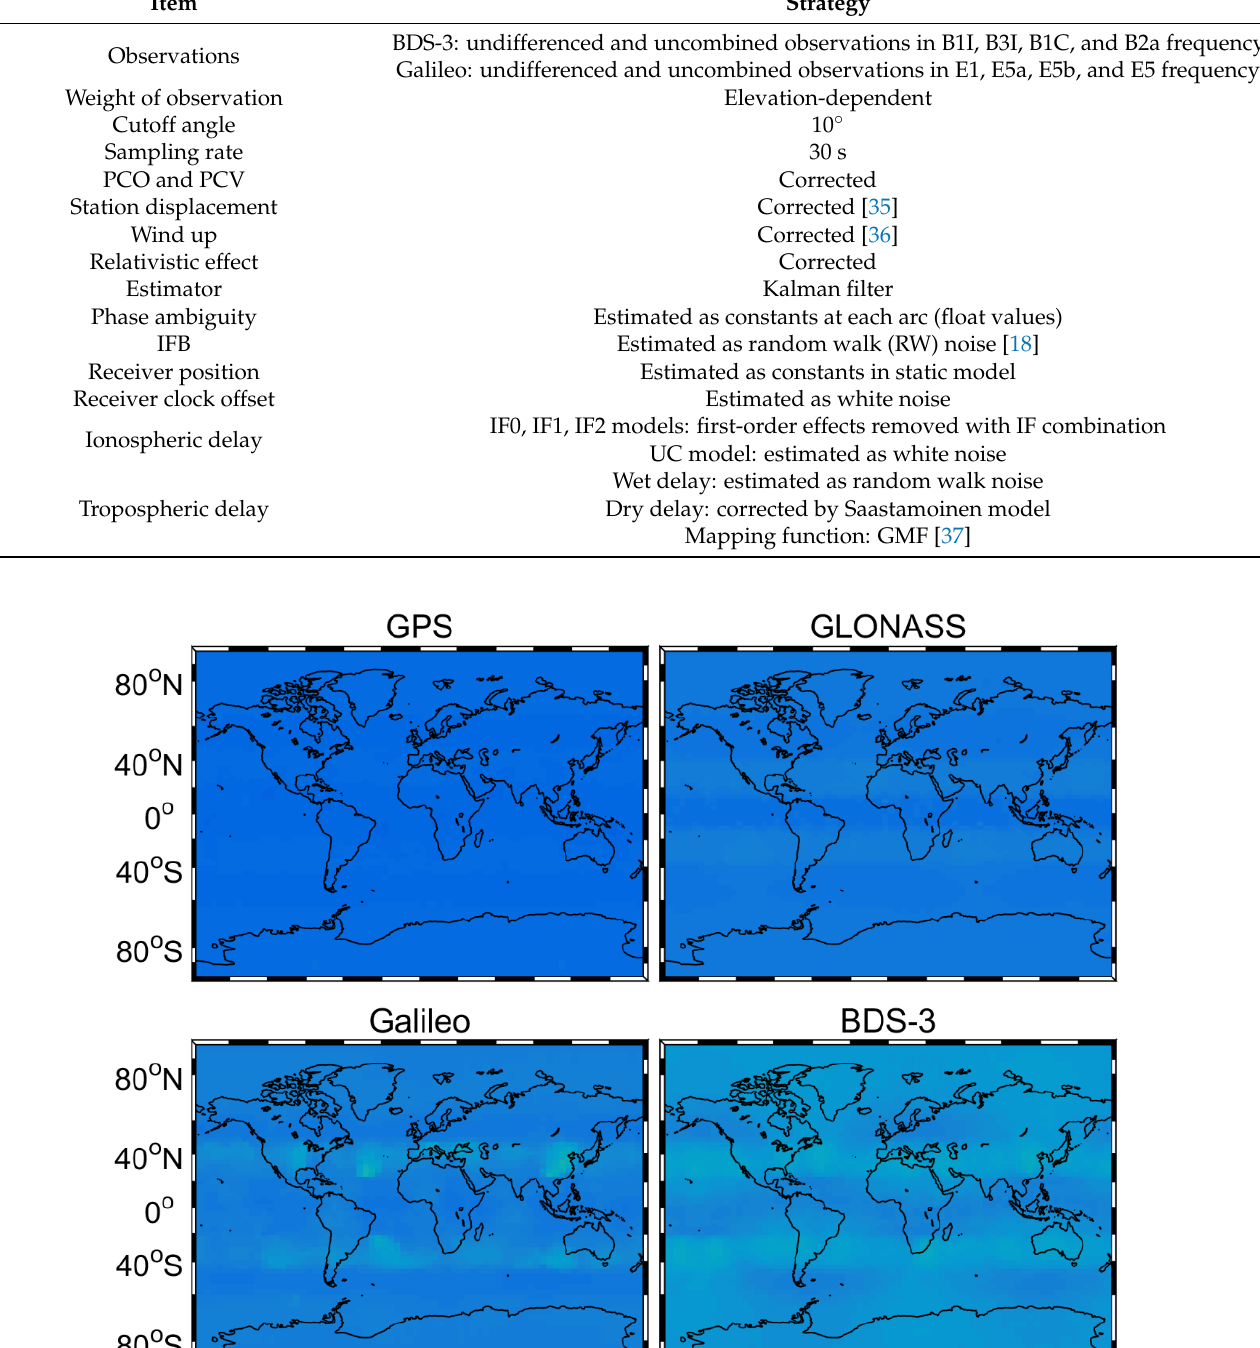
Table 4. Strategies for BDS-3 and Galileo IF0, IF1, IF2, and UC PPP time transfer model.